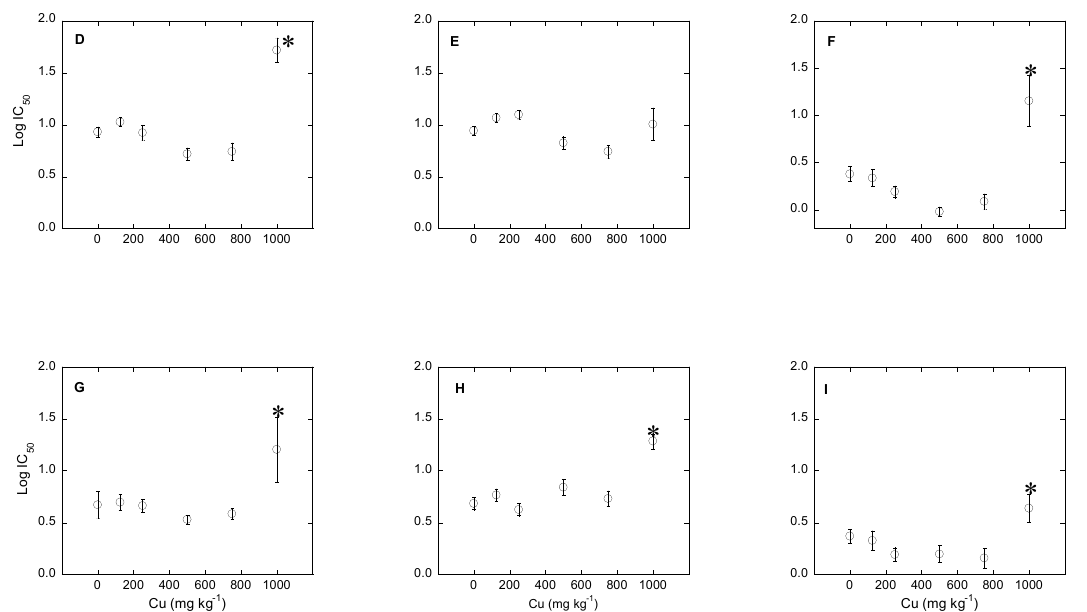
Figure 3. Variation of bacterial community tolerance to antibiotics (expressed as log IC 50 ), as a function of Cu concentration in the soil. ( A – C ): soil 1; ( D – F ): soil 2; and ( G – I ): soil 3. ( A , D , G ): tetracycline; ( B , E , H ): oxytetracycline; and ( C , F , I ): chlortetracycline. * Indicates significant increases in log IC 50 compared to the control log IC 50 ( p < 0.05).